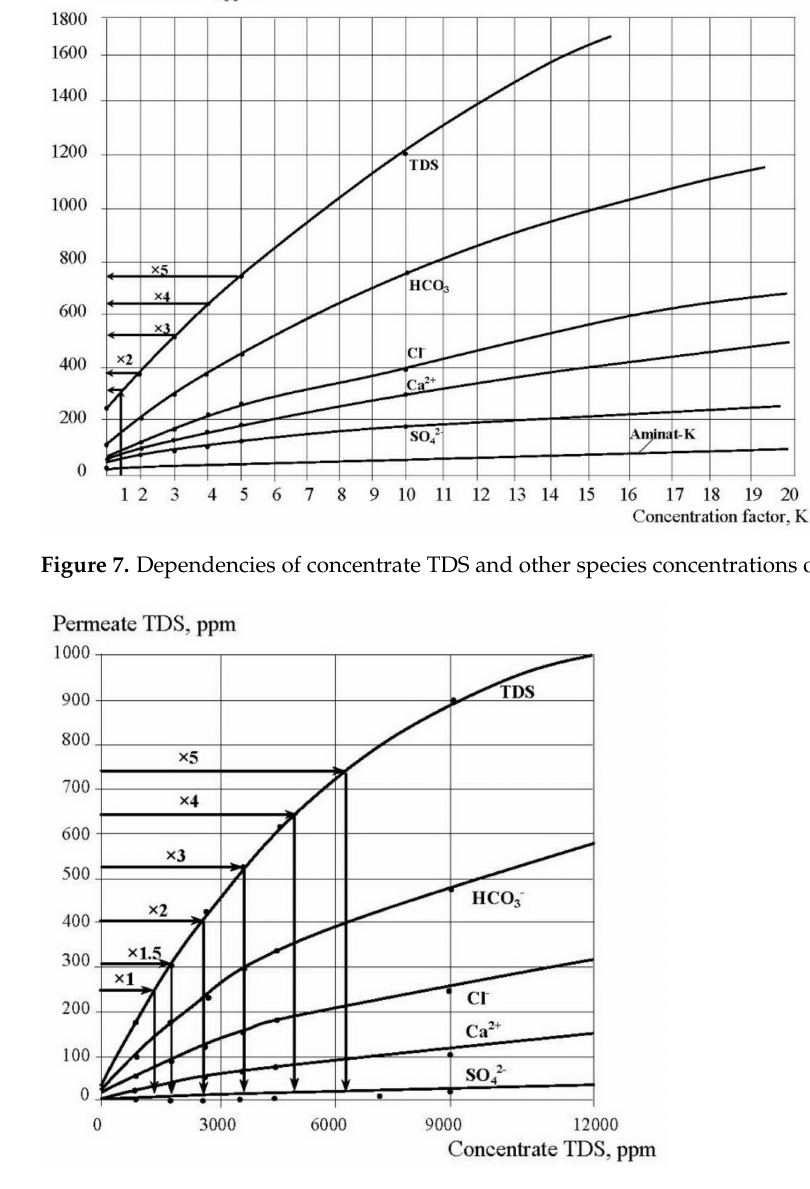
Figure 8. Dependencies of permeate TDS and concentrations of different species in concentrate on concentrate